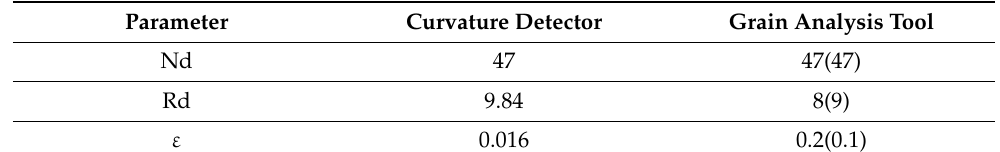
Table 2. Comparison of segmentation results by the curvature Detector and the GrainAnalysis tool (the results for the Grain Analysis tool are given for Figure 3c,d in parentheses).